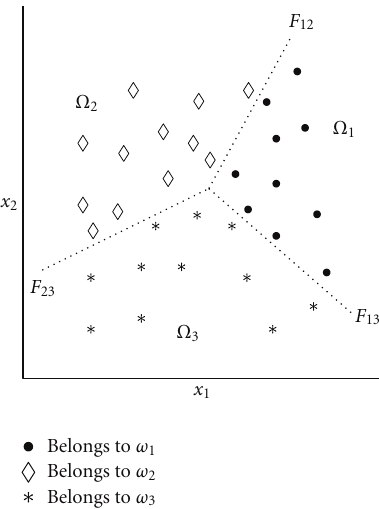
Figure 1: Class boundaries defined by linear discriminant functions for three classes of 2-dimensional